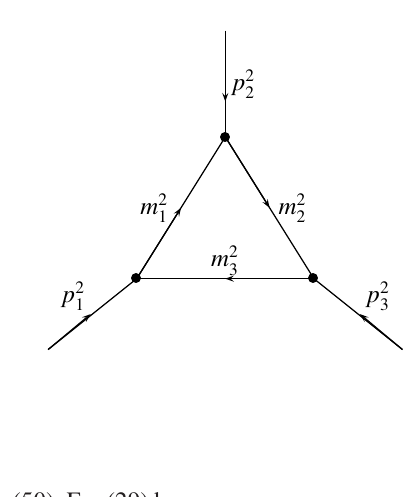
Figure 4. Triangle